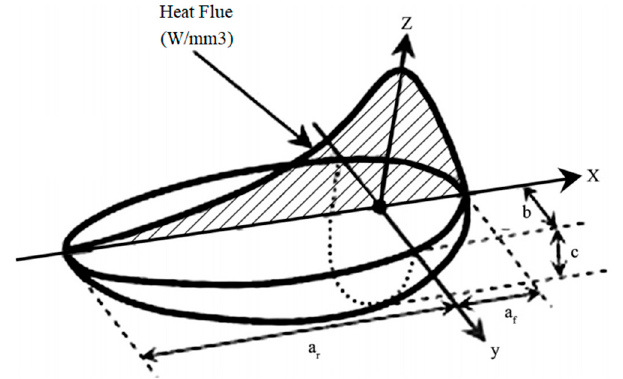
Figure 5. Double ellipsoid heat source model.